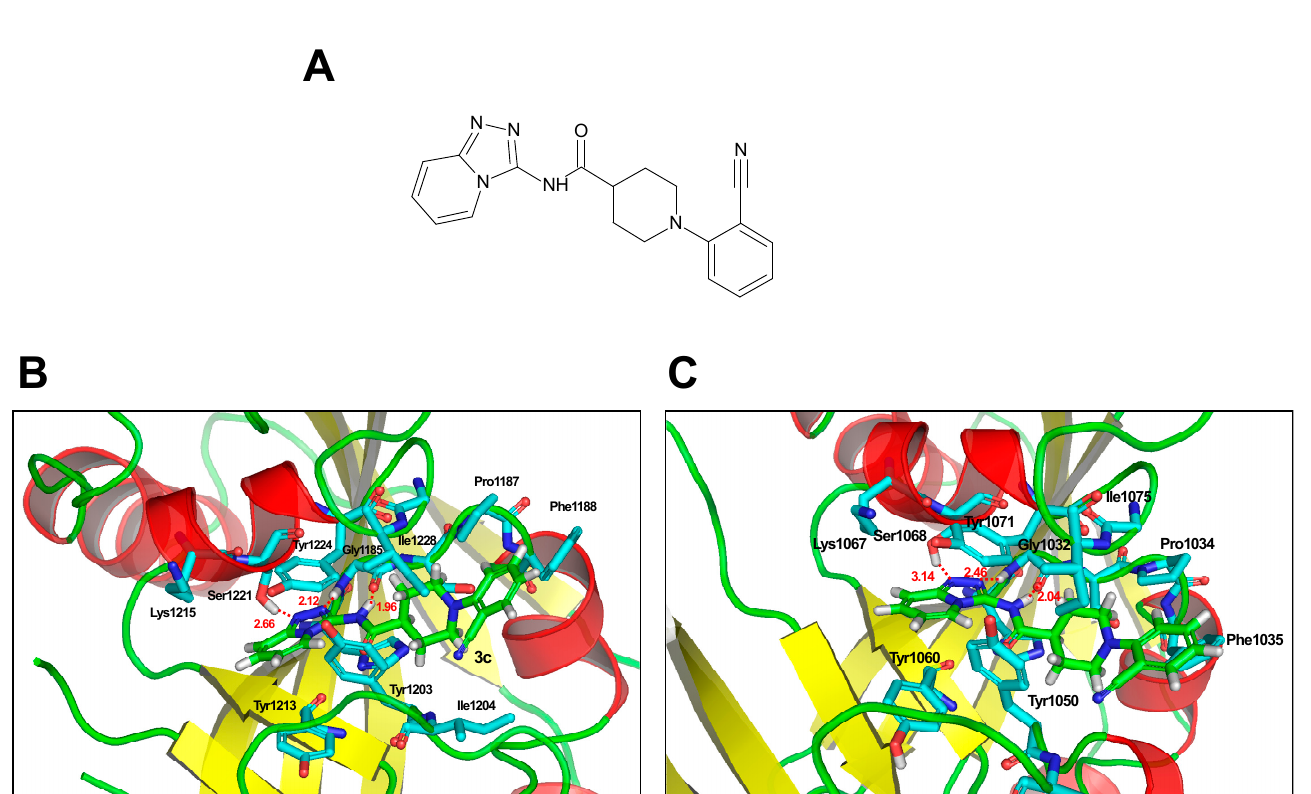
Figure 2. Predicted docking pose of TI-12403 in TNKS1 and TNKS2. ( A ) Chemical structure of TI-12403. ( B , C ) The analysis was performed by aligning the triazol ring atoms between TI-12403 and X-ray ligand (TNKS1; 4KRS.pdb, TNKS2; 3P0Q.pdb). Hydrogen bonds with relevant active site residues are shown as red dashes.